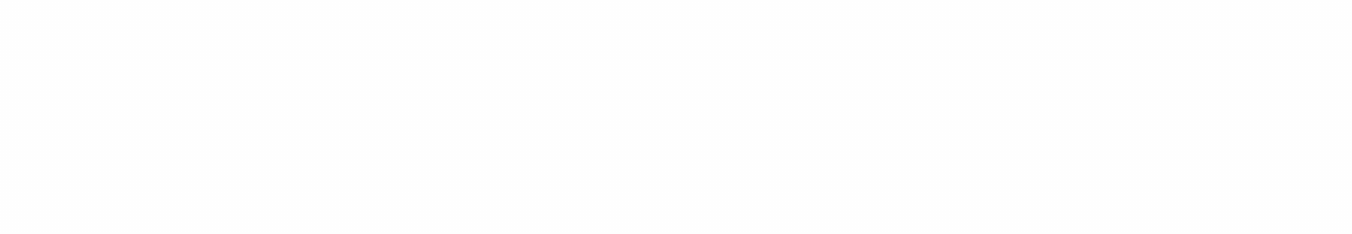
We recall that for a two-dimensional map the existence of a periodic orbit of period three is not related to the existence of chaotic dynamics, as it occurs in one-dimensional maps. This example is precisely a demonstration. In the case shown in Figure 7b the f-limit set of T (which includes the limit set of all the trajectories of the plane) includes only a few cycles of